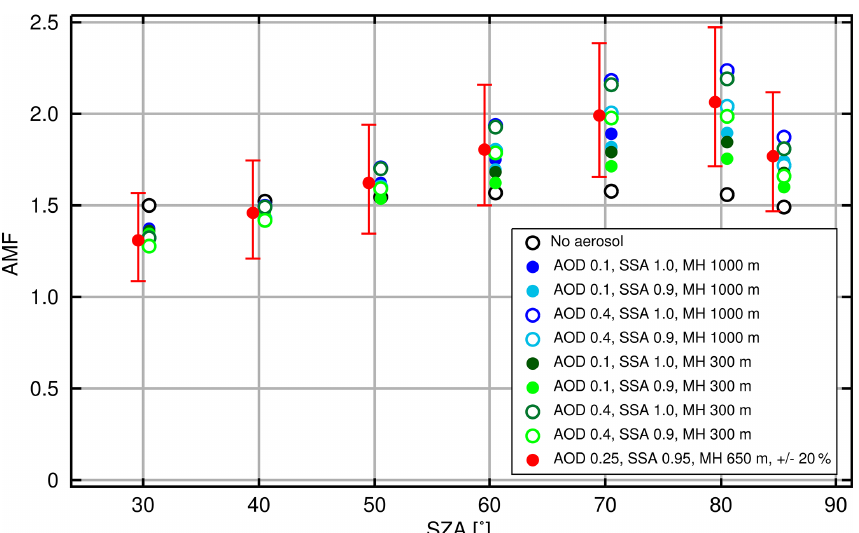
Figure 7. Simulated scenario-based tropospheric AMFs as a function of SZA. The red dots represent the tropospheric AMFs that are used for the conversion of DSCD meas into VCD tropo in this study (see Eq. 1); error bars indicate ± 20%. The other scenarios are depicted by circles and dots.